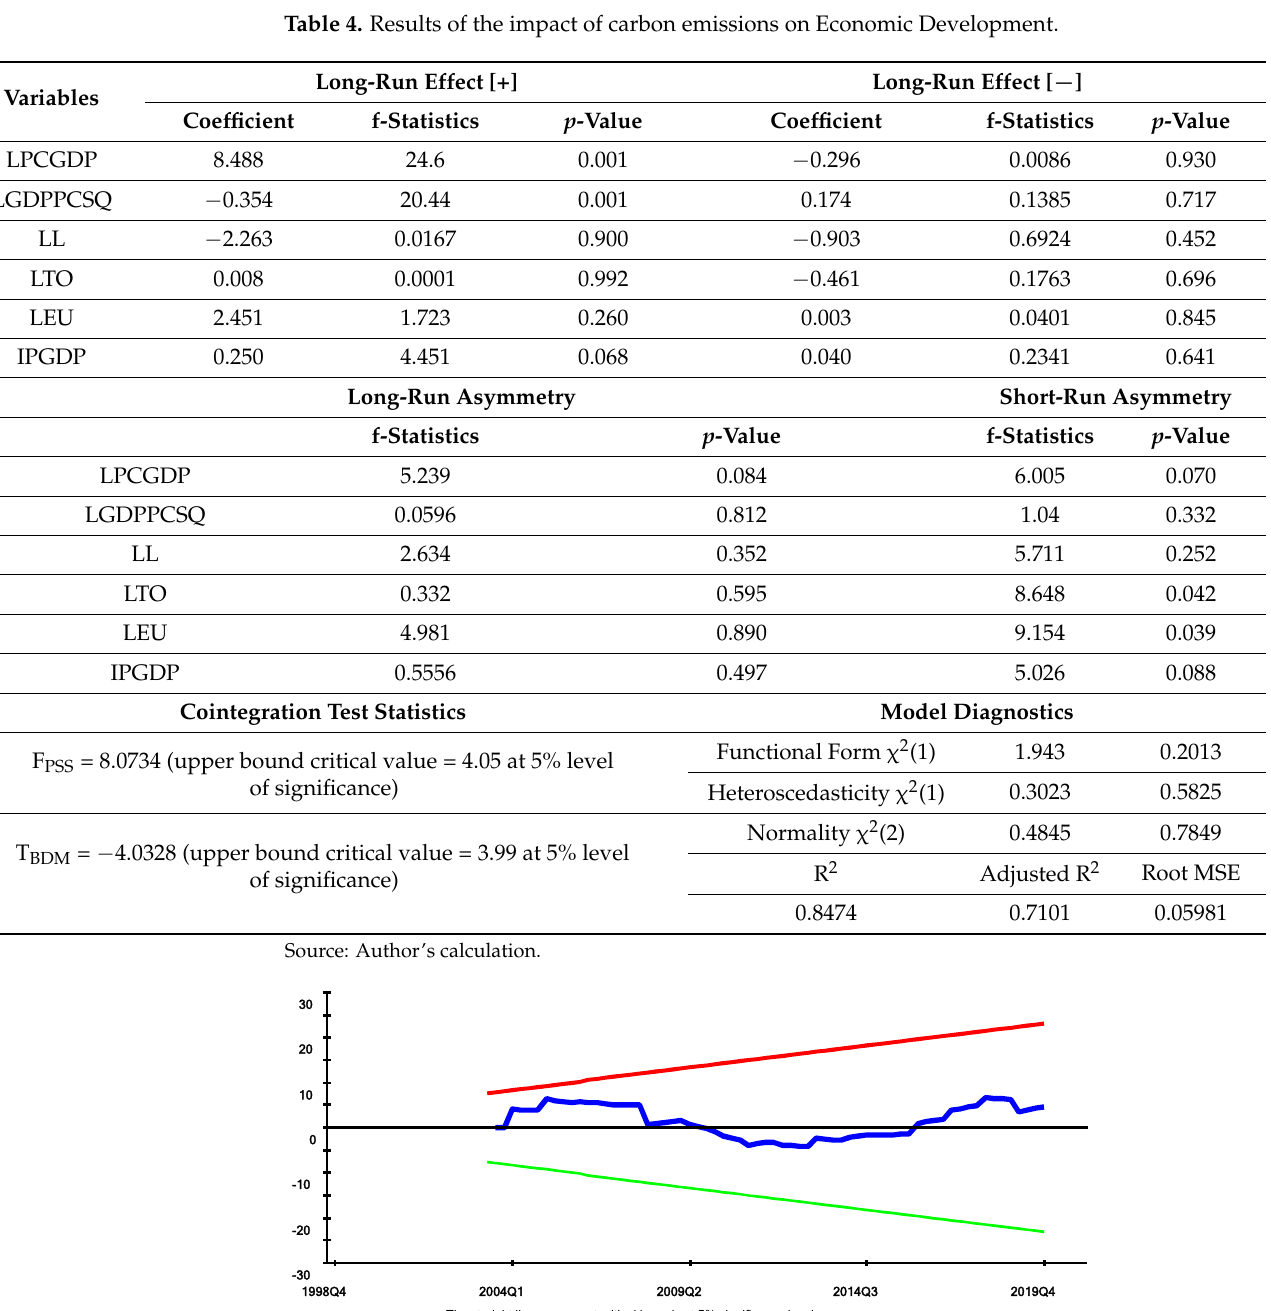
Figure 3. Plot of Cumulative Sum of Squares Recursive residuals. Source: Author’s Calculation. 4.3. Empirical Findings from Asymmetric ARDL Model Table 4 indicates the results from asymmetric ARDL both for the long run and short run. The values of FPSS and TBDM depict that the null hypothesis of no cointegration is rejected under the assumption of short-run and long-run asymmetry in the model. The estimates obtained by using the standard ARDL framework also fail to detect asymmet- ric long-run relationships among variables included in the model. Table 4 shows that the short run and long run asymmetry has been detected by the NARDL estimator effi- ciently. Furthermore, Table 4 indicates that the long run coefficients of GDPPC+ are 8.48 and GDPPC− is −0.29 respectively. Statistically, when there is a one percent increase in GDP per capita, the increase in carbon emissions will be 8.48%, whereas a decline in